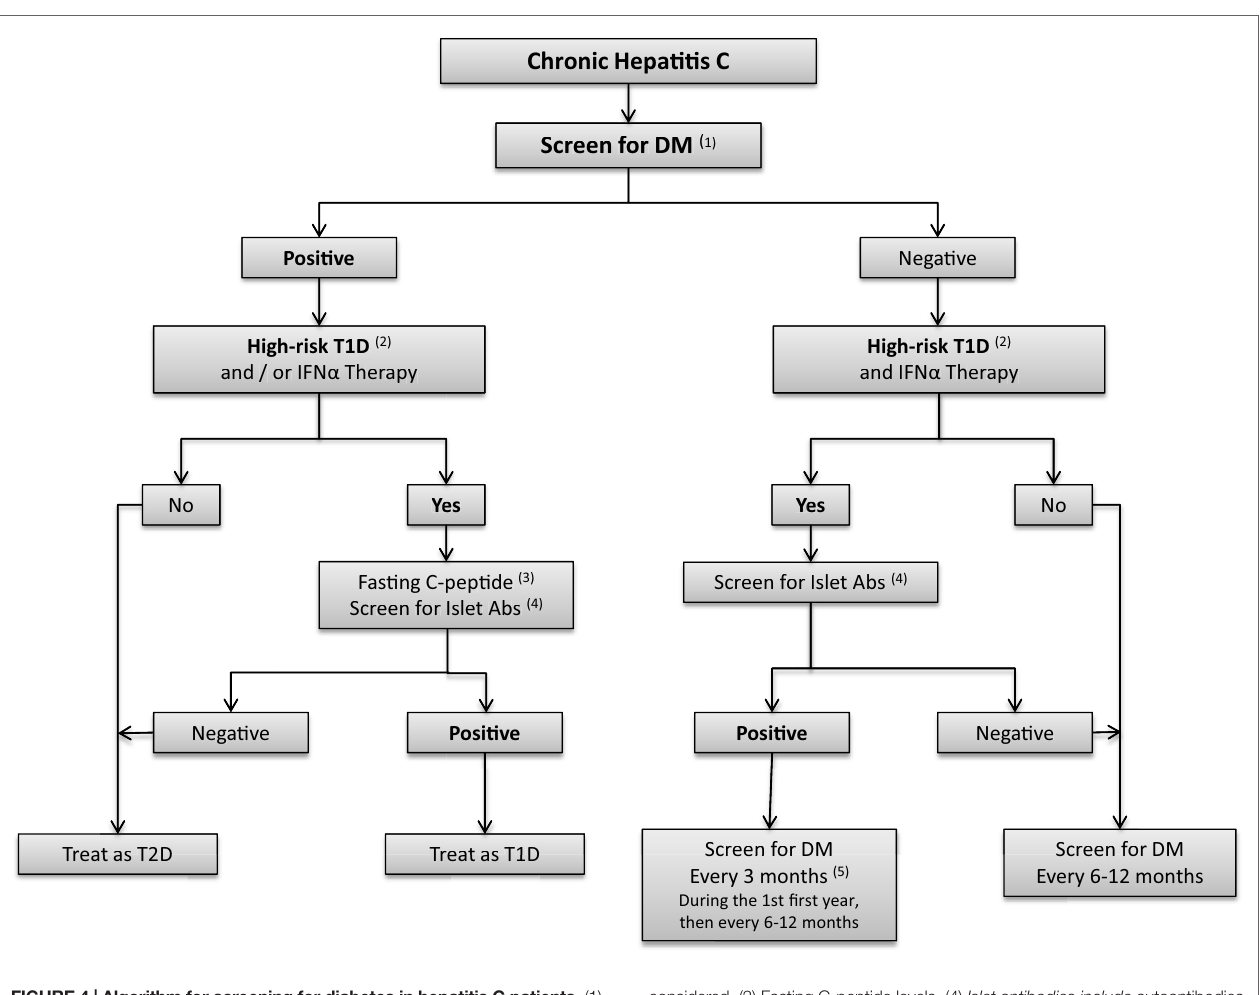
FiGURe 4 | Algorithm for screening for diabetes in hepatitis C patients . (1) Screen for DM : fasting blood sugar (FBS) and/or oral glucose tolerance test (OGTT). HbA 1 c might be considered if the measurement methods are well established. (2) High risk Type 1 diabetes patients are defined as individuals with first degree relatives with type 1 diabetes (T1D); patients with other autoimmune conditions; or patients might be considered as high risk, if IFN α therapy is